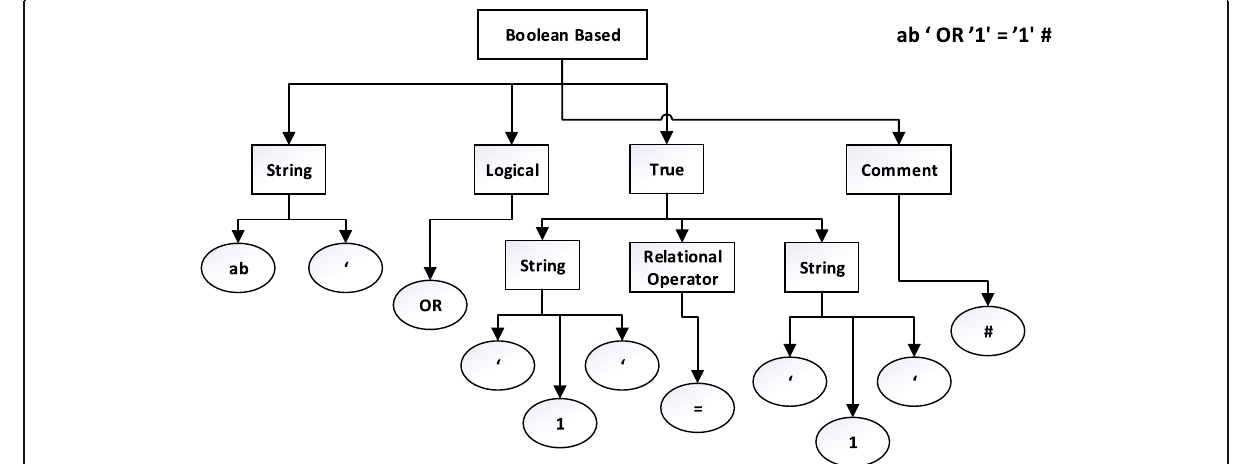
Fig. 1 Parse tree to depict Boolean-based SQL injection attacks. (ii). Union-based SQL injection string